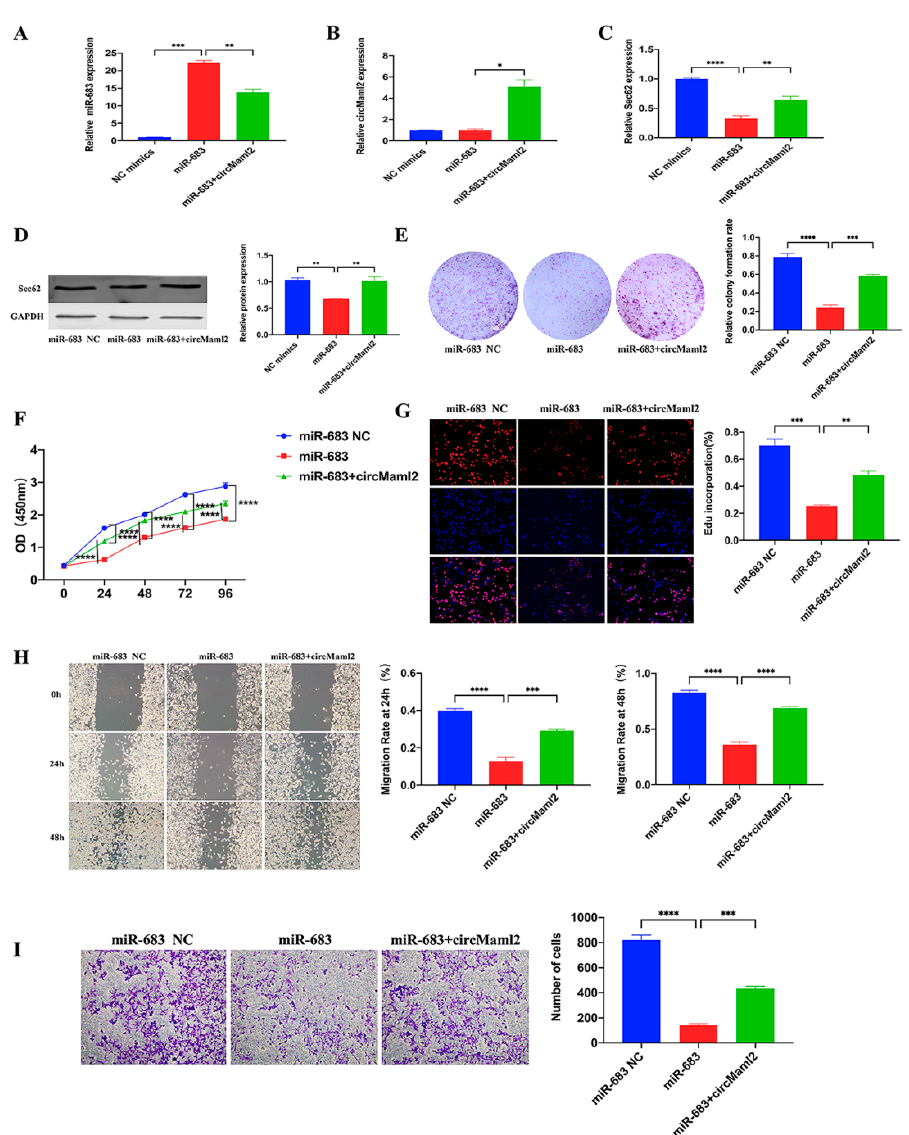
Figure 6. CircMaml2 Rescues the Inhibition of miR-683. ( A , B ) Expression of miR-683 and circMaml2 after the up-regulation of miR-683 and circMaml2 was detected by qRT-PCR (*** p = 0.0004, ** p = 0.0058, * p = 0.0113, ordinary one-way ANOVA). ( C , D ) mRNA and protein expression of Ebf1 was reversed successfully by co-transfection of circMaml2 and miR-683 (**** p < 0.0001, ** p < 0.0062, ** p = 0.0059, ** p = 0.0081, ordinary one-way ANOVA). ( E – I ) The cell proliferation and migration ability was rescued by circMaml2 (**** p < 0.0001, *** p < 0.0006, ordinary one-way ANOVA; **** p < 0.0001, two-way ANOVA; *** p = 0.0002, ** p = 0.0064, **** p < 0.0001, *** p = 0.0005, **** p < 0.0001, *** p = 0.0005, ordinary one-way ANOVA). All data are presented as mean + SEM. ns, not significant. n = 3.